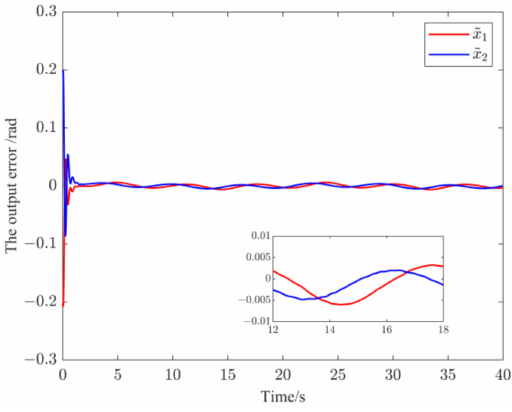
Figure 5. The output error (cid:101) x .